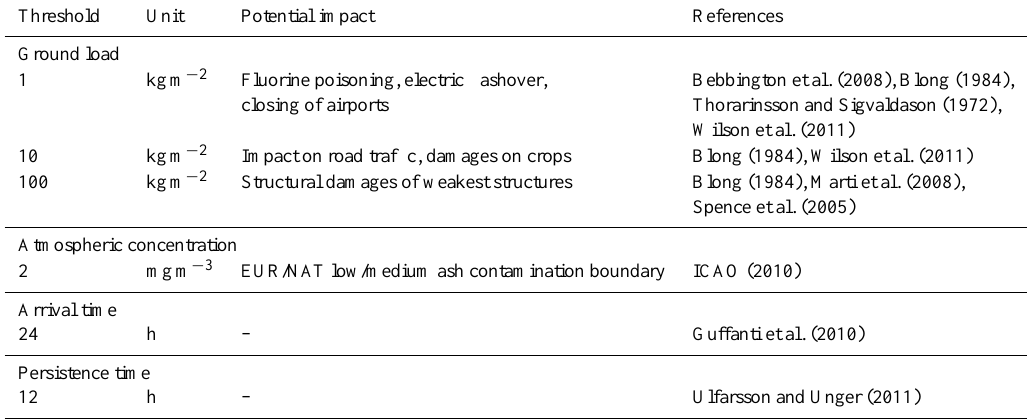
Table 4. Critical thresholds for probability